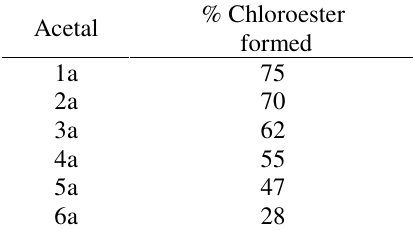
Table 2. Percentage distribution of ring chlorinated ester products of acetals by the action of